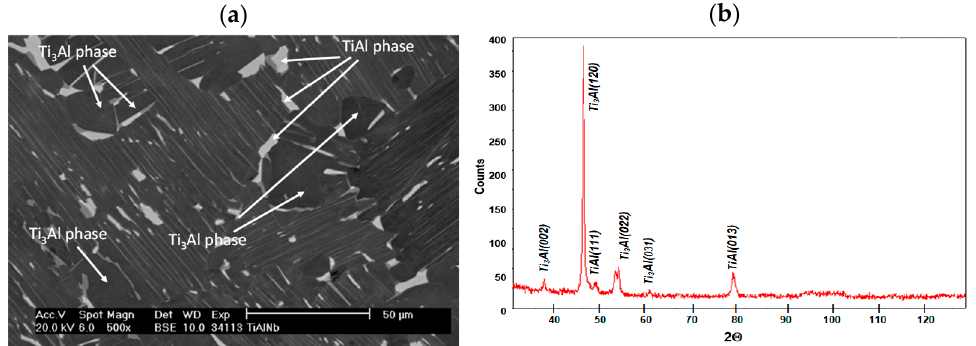
Figure 1. The ( a ) structure and ( b ) XRD microanalysis results of the Ti–46Al–7Nb–0.7Cr–0.1Si– 0.2Ni alloy.